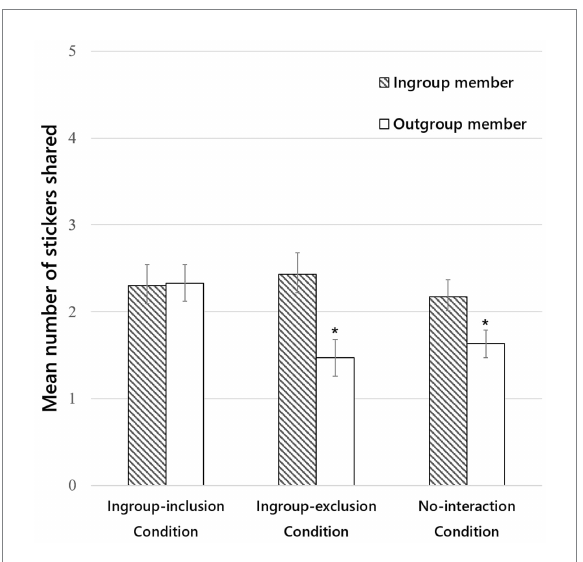
FIGURE 2 Mean number of stickers children shared with the ingroup or outgroup member. Error bars represent standard